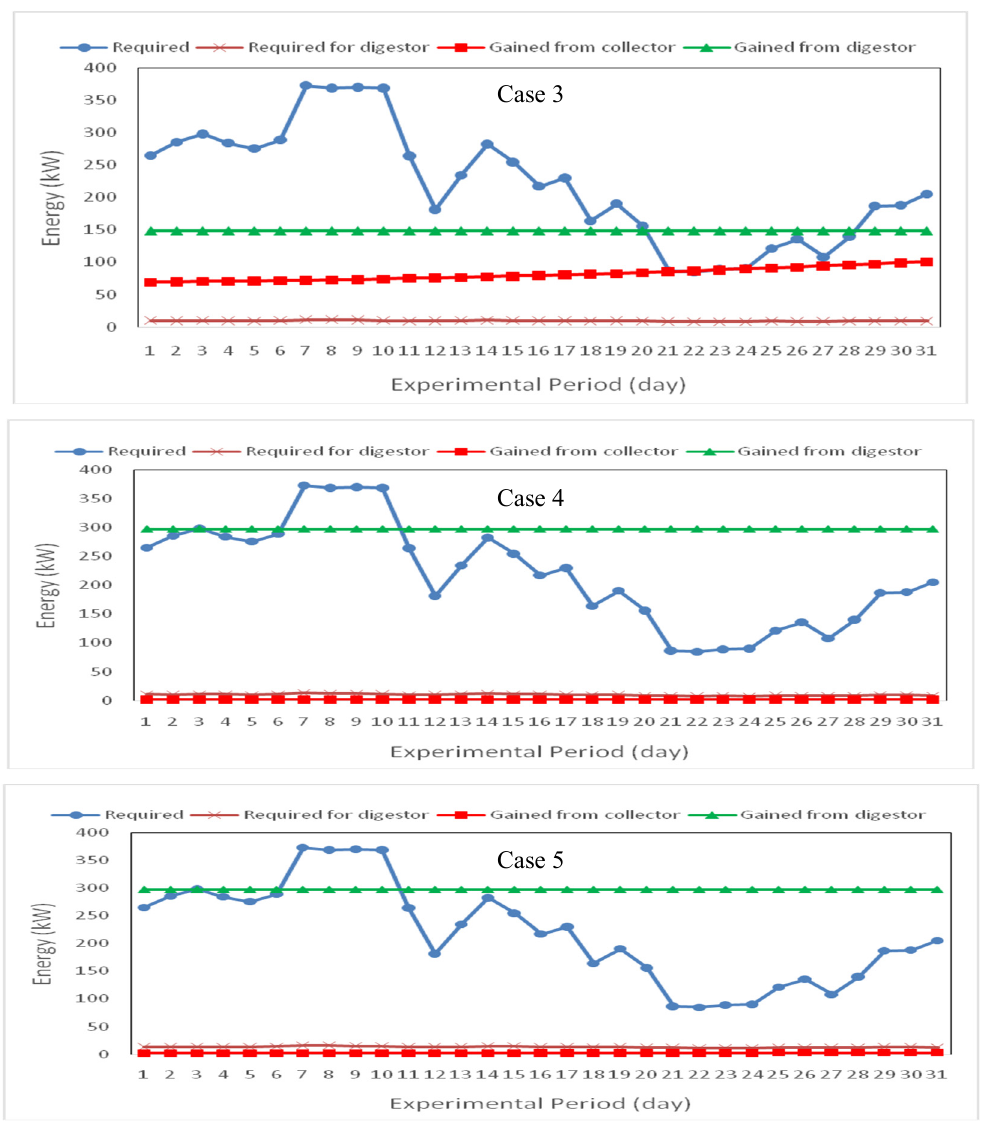
Figure 10. Energy requirement for heating and energy gained by solar collector and biogas digester for di ff erent bio-solar house case studies during winter season. Case 1. Heating the house with solar energy; Case 2. Heating the house and the biogas digester with solar energy during daylight and with biogas at night (temperature of the biogas digester is 309.15 K and retention time is 35 days); Case 3. Heating the house and biogas digester with solar energy during daylight and with biogas at night (temperature of biogas digester is 322.15 K and retention time is 17.5 days); Case 4. Heating the house with biogas while the biogas digester is heated by solar energy (temperature of biogas digester is 309.15 K and retention time is 35 days); Case 5. Heating the house with biogas while the biogas digester is heated by solar energy (temperature of biogas digester is 322.15 K and retention time is 17.5 days).